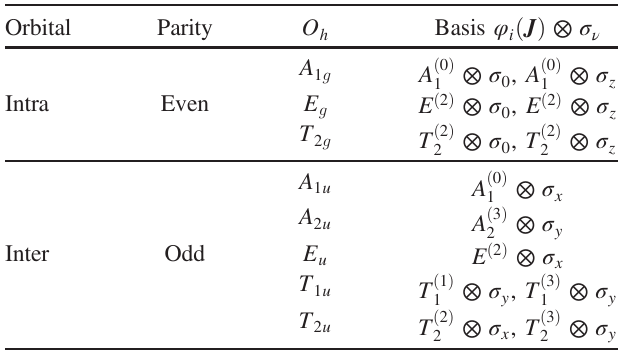
TABLE II. Eight classes of the whole basis of the gap function according to O -point-group symmetry. The columns denote h intraorbital or interorbital pairing, irreducible representation of O -point-group symmetry, and the basis matrix given as the h direct product of spin basis in O representation and Pauli matrices for the orbital